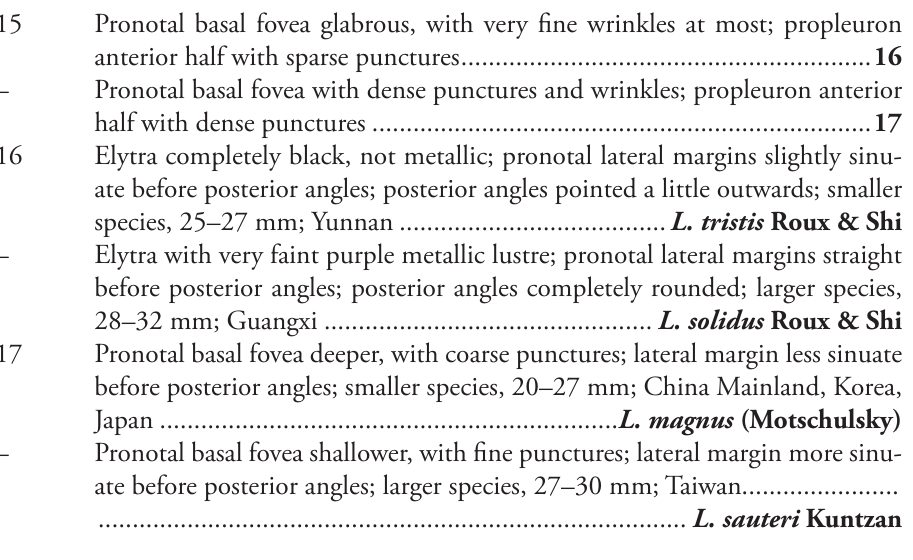
Pronotal basal fovea glabrous, with very fine wrinkles at most; propleuron – Pronotal basal fovea with dense punctures and wrinkles; propleuron anterior 16 Elytra completely black, not metallic; pronotal lateral margins slightly sinu- ate before posterior angles; posterior angles pointed a little outwards; smaller